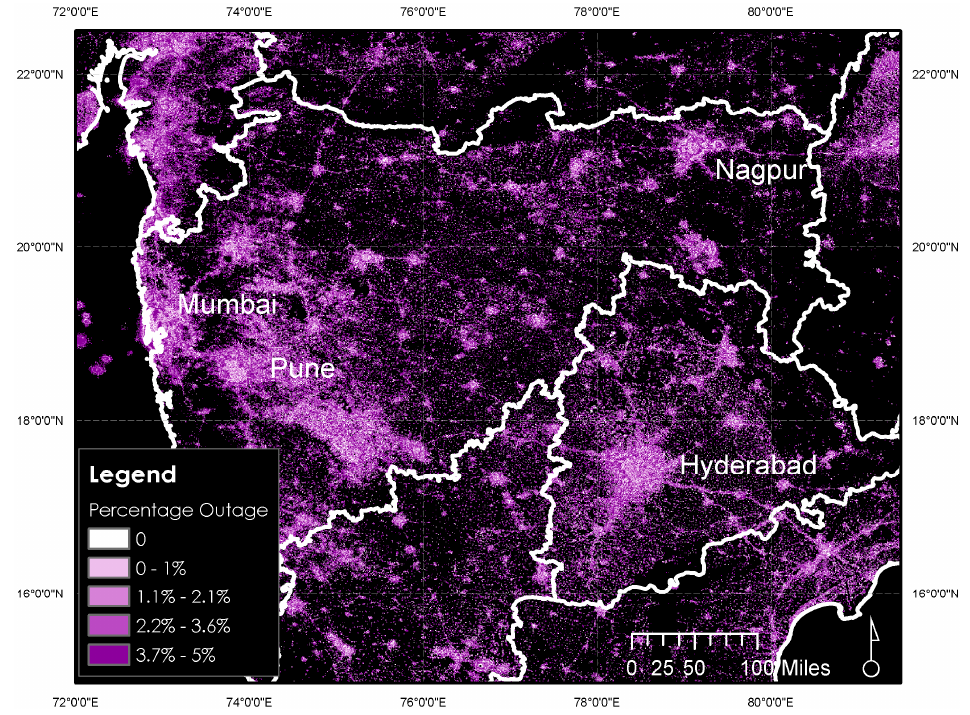
Figure 6. Estimates of electricity outage rates for Maharashtra and surrounding states . Outage rates for cloud-free days are presented on a low to high scale ( white to purple ), with state boundaries highlighted ( white lines ).